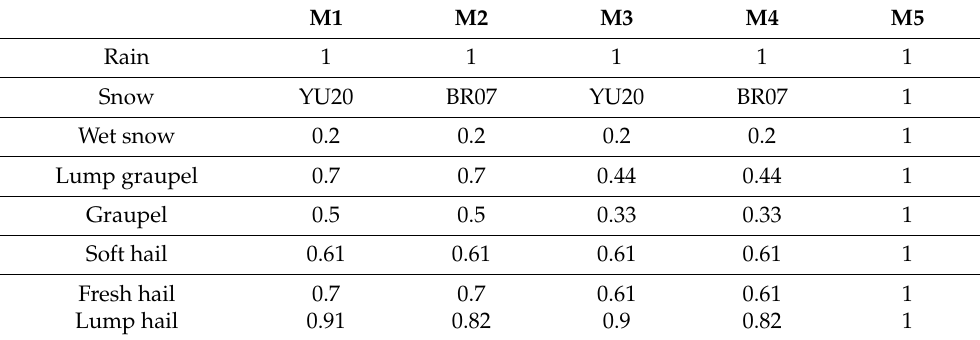
Table 3. Set of density values (in g cm − 3 ) for each type of hydrometeor in proposed models. For models 1–4, we applied the snow density-diameter relationships reported by Brandes et al. [61] (BR07) or Yu et al. [62] (YU20), while a constant value was assumed for the other hydrometeors. Model 5 assumed the density of all hydrometeors equals water density (1 g cm − 3 ). Thus, the given values represent the a -parameter along with b = 0 fulfill the power-law expression ρ = aD b . M1 M2 M3 M4 M5 Rain 1 1 1 1 1 Snow YU20 BR07 YU20 BR07 1 Wet snow 0.2 0.2 0.2 0.2 1 Lump graupel 0.7 0.7 0.44 0.44 1 Graupel 0.5 0.5 0.33 0.33 1 Soft hail 0.61 0.61 0.61 0.61 1 Fresh hail 0.7 0.7 0.61 0.61 1 Lump hail 0.91 0.82 0.9 0.82